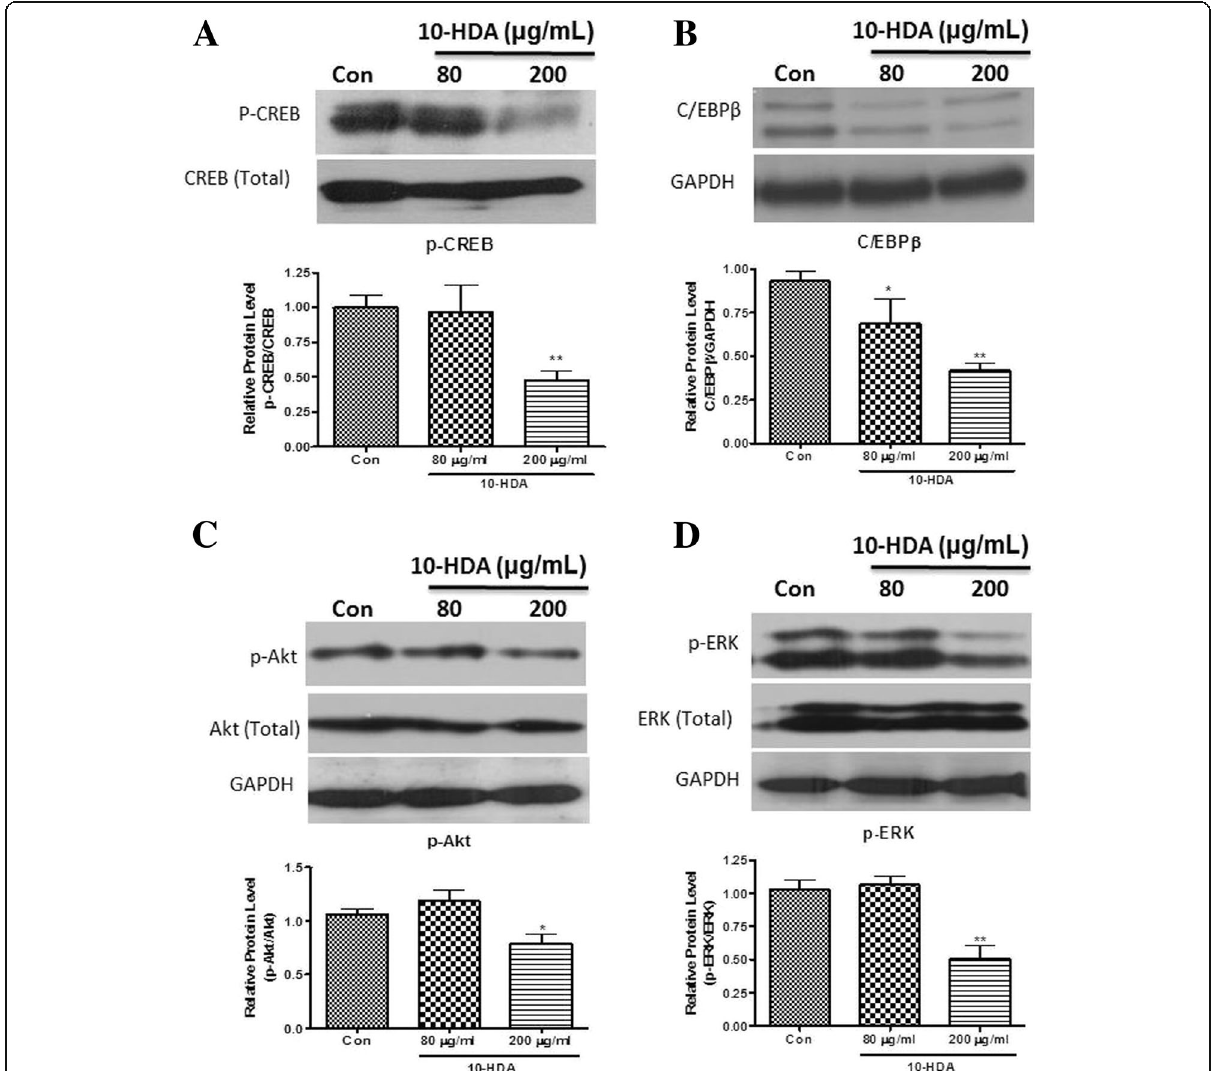
Fig. 6 Effect of 10-HDA on the early stage of adipogenesis in 3 T3-L1 adipocytes. The blot represented the protein expression levels of ( a ) p-CREB, ( b ) C/EBP β , ( c ) p-Akt, and ( d ) p-ERK. The band intensities of ( a ) p-CREB, ( c ) p-Akt, and ( d ) p-ERK were measured and normalized to total protein level of the respective protein, whereas, the band intensity of ( b ) C/EBP β was normalized to GAPDH. The data shown are presented as means ± SD of triplicate experiments. Statistical significance was calculated using one-way ANOVA followed by Dunnett ’ s multiple comparisons test. * P <0.05 vs control; ** P <0.01 vs